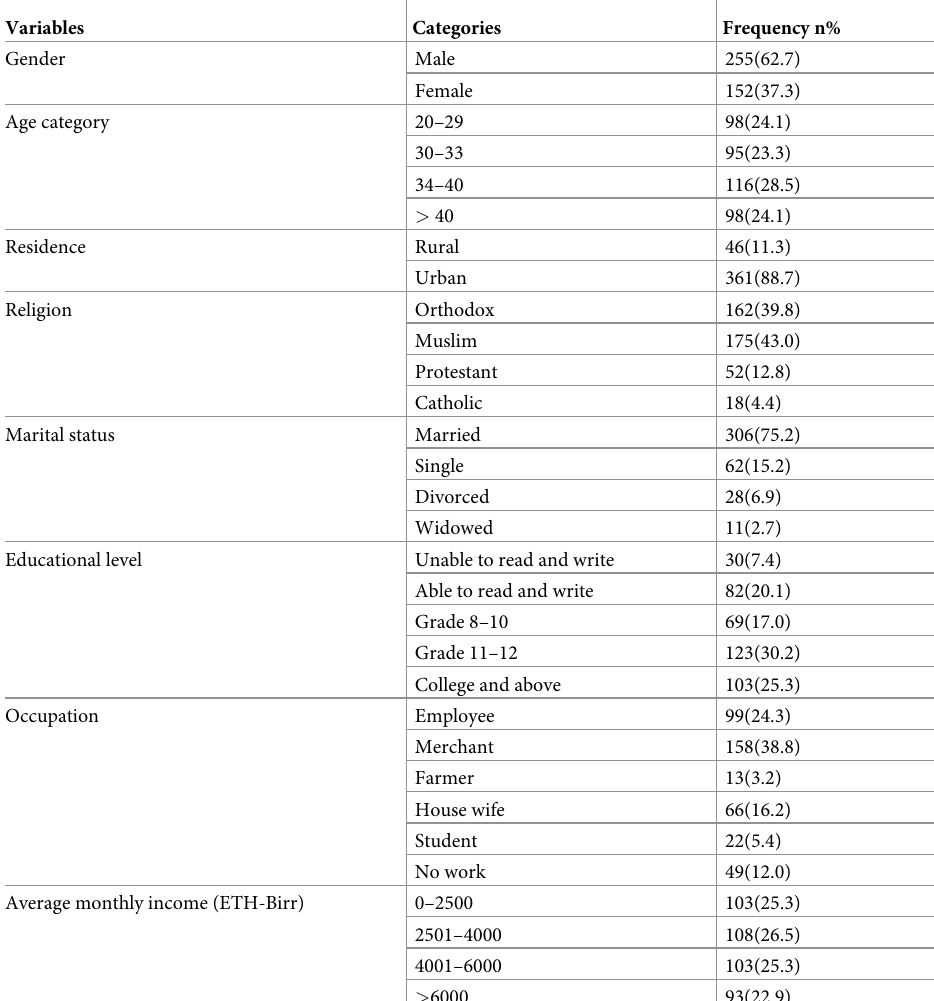
Table 1. Socio-demographic characteristics of the study participants among adults in Dessie City, Northeast Ethi- opia, 2021 (n =